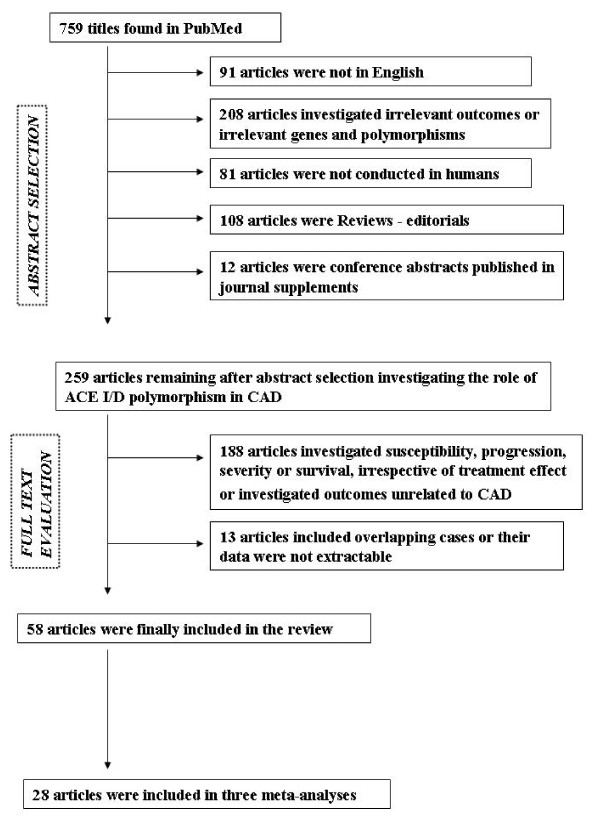
Flow chart of retrieved studies and studies excluded, with specification of reasons.